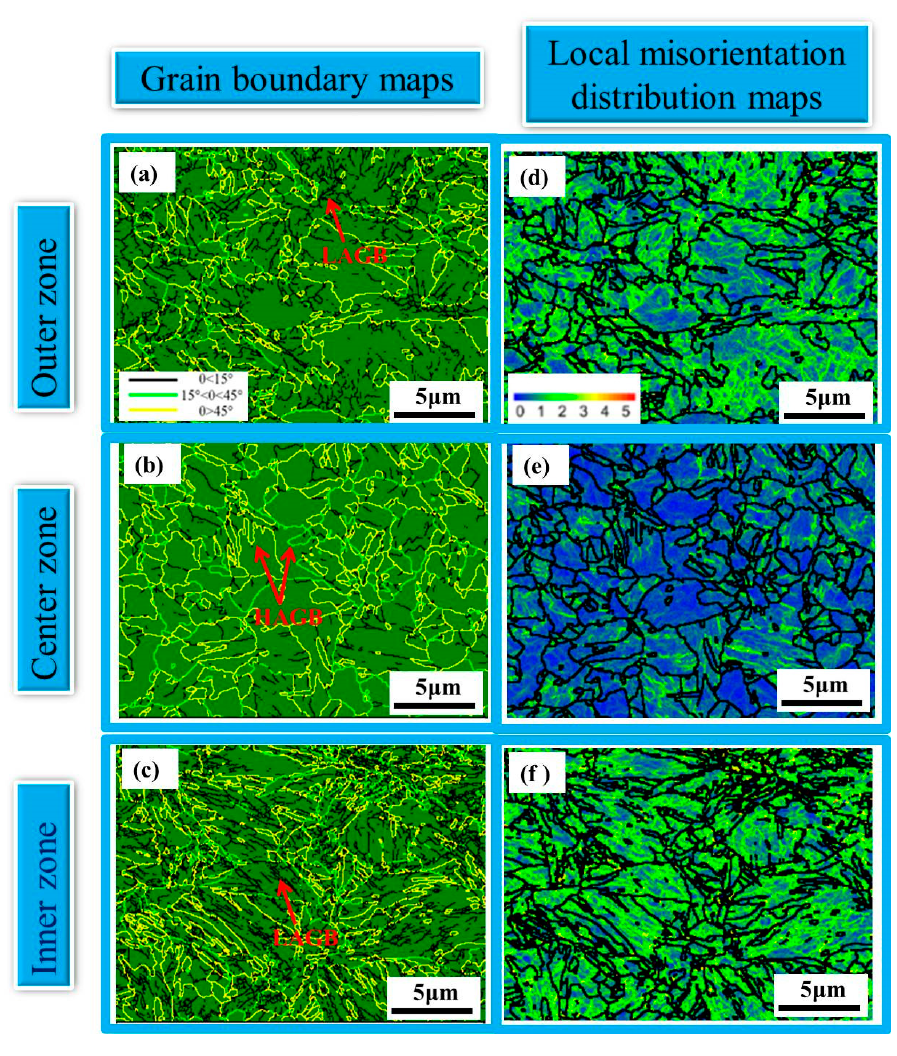
Figure 4. EBSD analysis for outer zone ( a , d ), center zone ( b , e ), and inner zone ( c , f ) of the bending specimen at 74° angle: EBSD grain boundary maps (left), and EBSD local misorientation distribution maps (right).